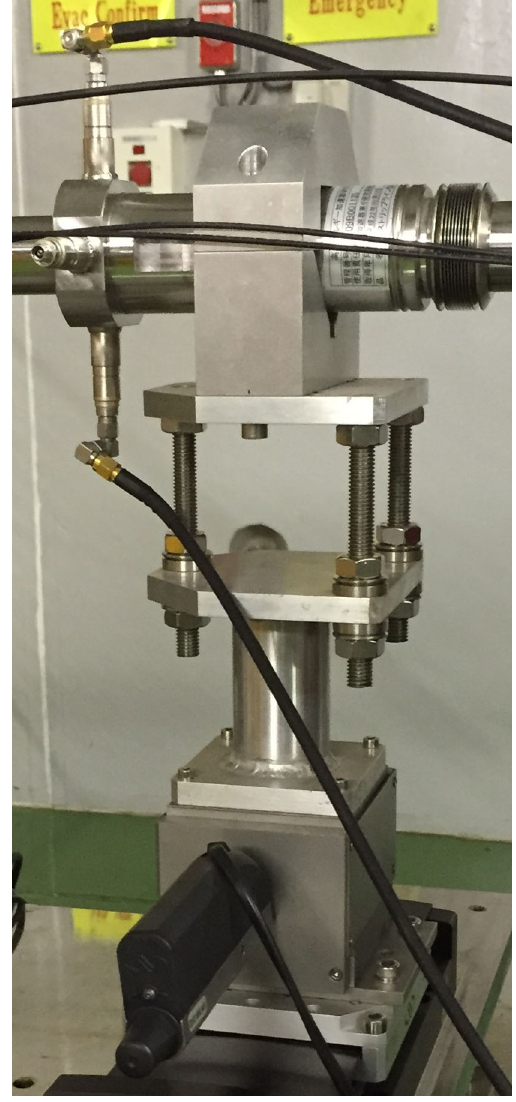
FIG. 9. Photograph of the stripline BPM P3 and its mover in the ATF beam